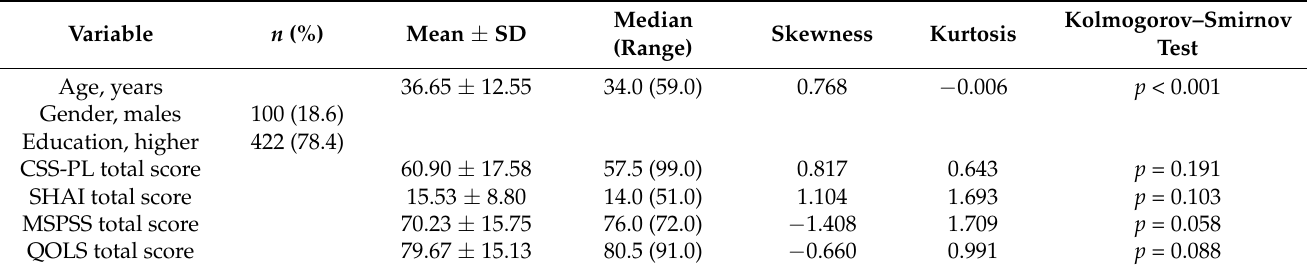
Table 1. General characteristics of the sample ( n =